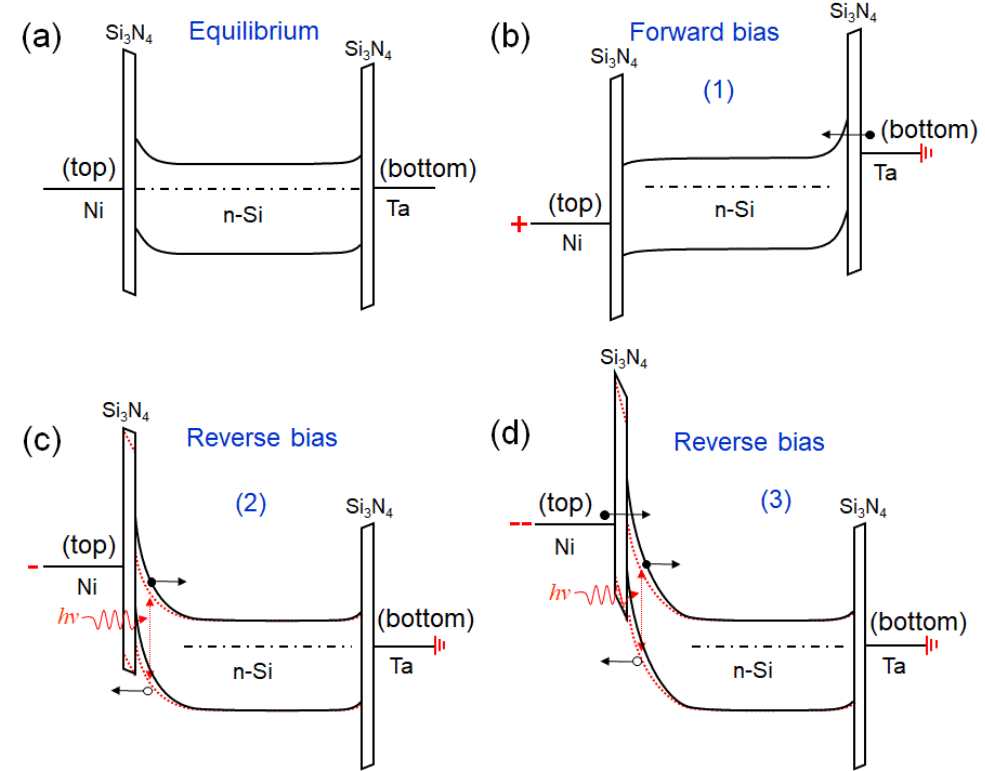
Figure 6. Band diagrams of the Pt - Ta_CNT/Si 3 N 4 /n-Si/Si 3 N 4 /Ta MISIM heterostructure in equilibrium: ( a ) forward, ( b ) lower, ( c ) higher, and ( d ) reverse bias. The red dotted curves represent the bands under illumination. Empty and full circles represent holes and electrons, respectively.